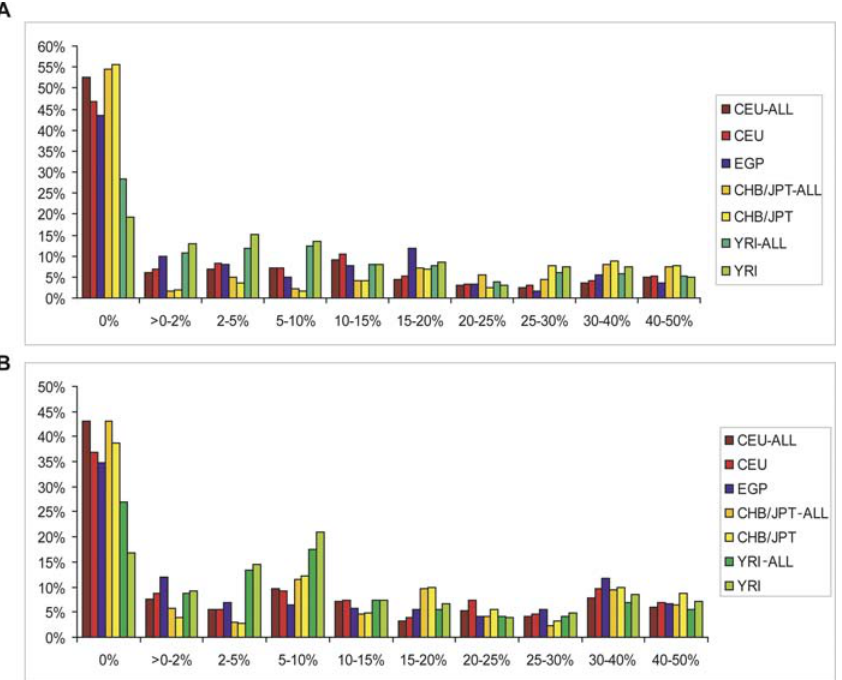
Figure 2. Distribution of Allelic Frequency of the Selected SNPs (A) Distribution in the ENCODE 1 (2p16.3) region. (B) Distribution in the ENCODE 2 (2q37.1) region. The -ALL groups refer to the entire set of markers typed in the HapMap project. DOI: